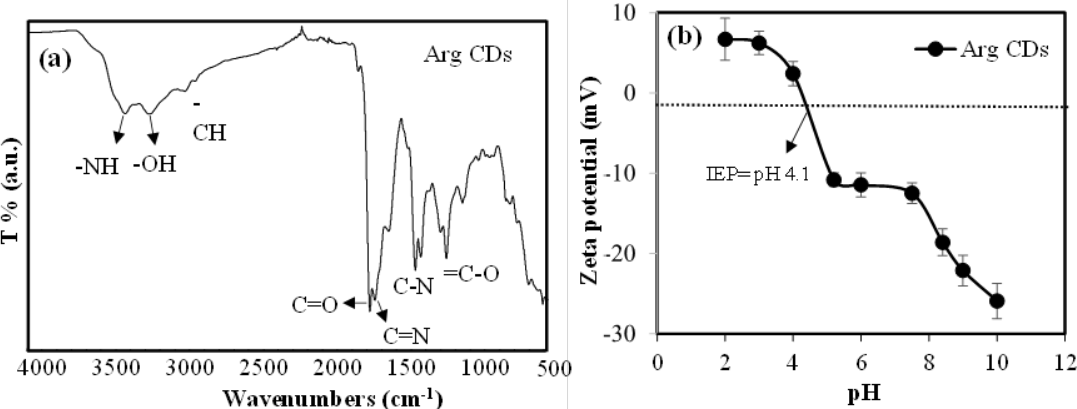
Figure 2. ( a ) FT-IR spectrum of Arg CDs. ( b ) Zeta potential values of Arg CDs at different pH conditions from 2 to 10 and its isoelectronic points.